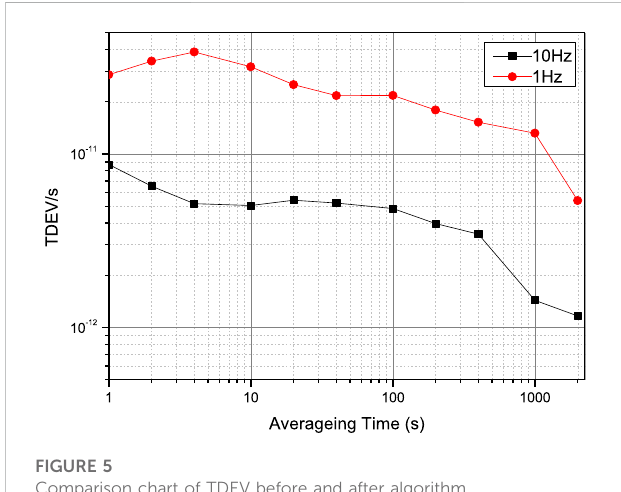
FIGURE 7 TDEV of the 1 PPS time transfer at different remote